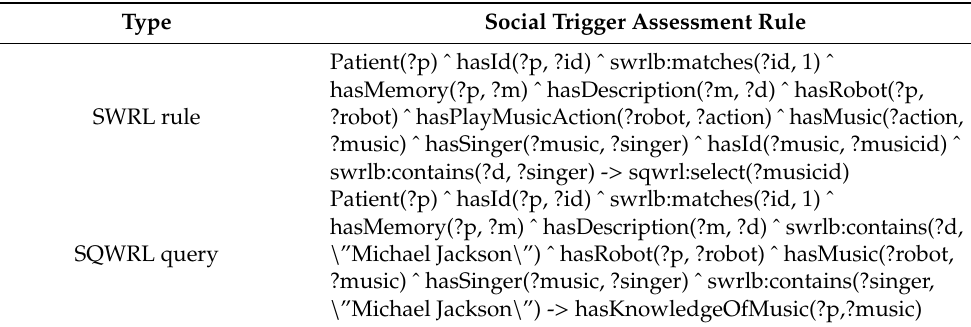
Table 5. Example of social triggers assessment